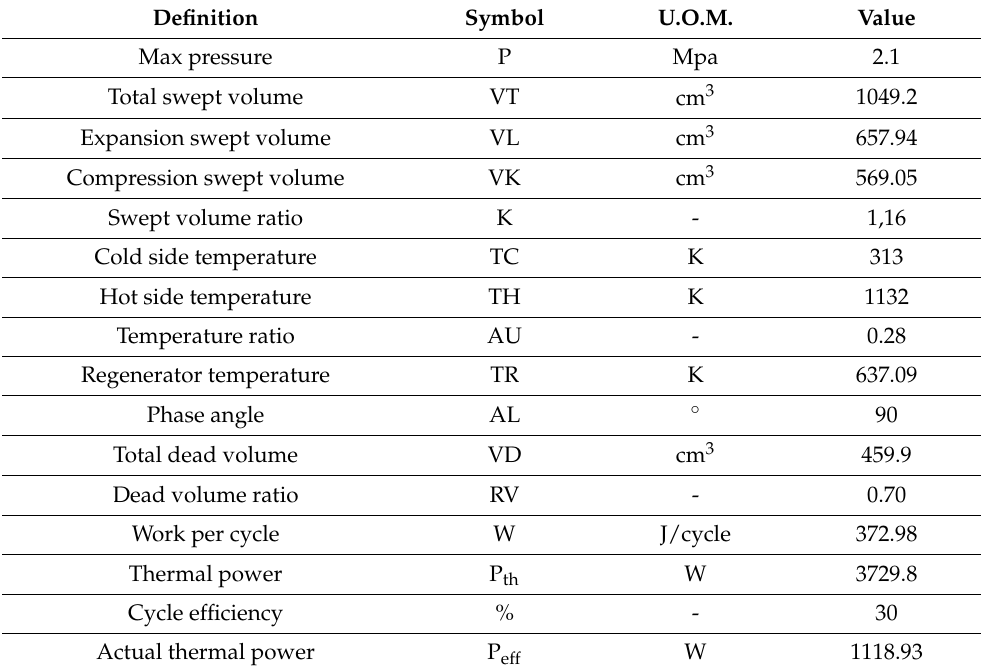
Table 7. Second-order